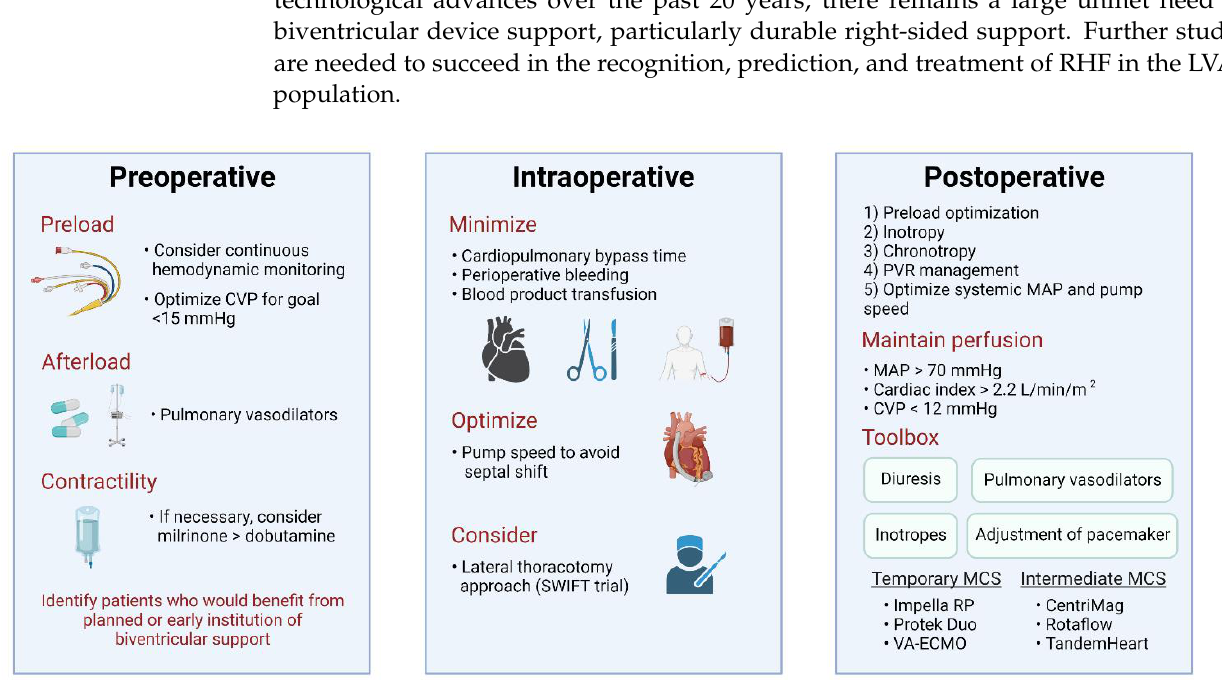
Figure 3. Management of right heart failure with left ventricular assist device placement. CVP = central venous pressure; LV = left ventricle; MAP = mean arterial pressure; MCS = mechanical circulatory support; PVR = pulmonary vascular resistance; VA-ECMO = veno-arterial extracorporeal membrane oxygenation. Created with BioRender.com, accessed on 22 April 2022.